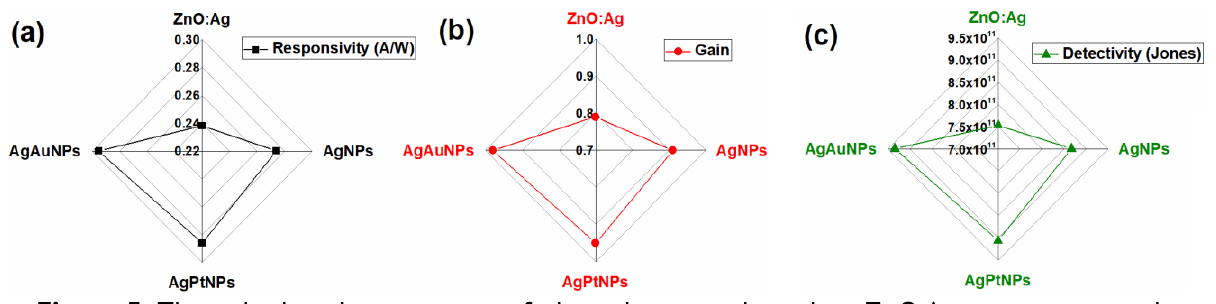
Figure 5. The calculated parameters of photodetectors based on ZnO:Ag nanostructured films: (a) Responsivity (A/W); (b) Photoconductive gain; and (c) Detectivity